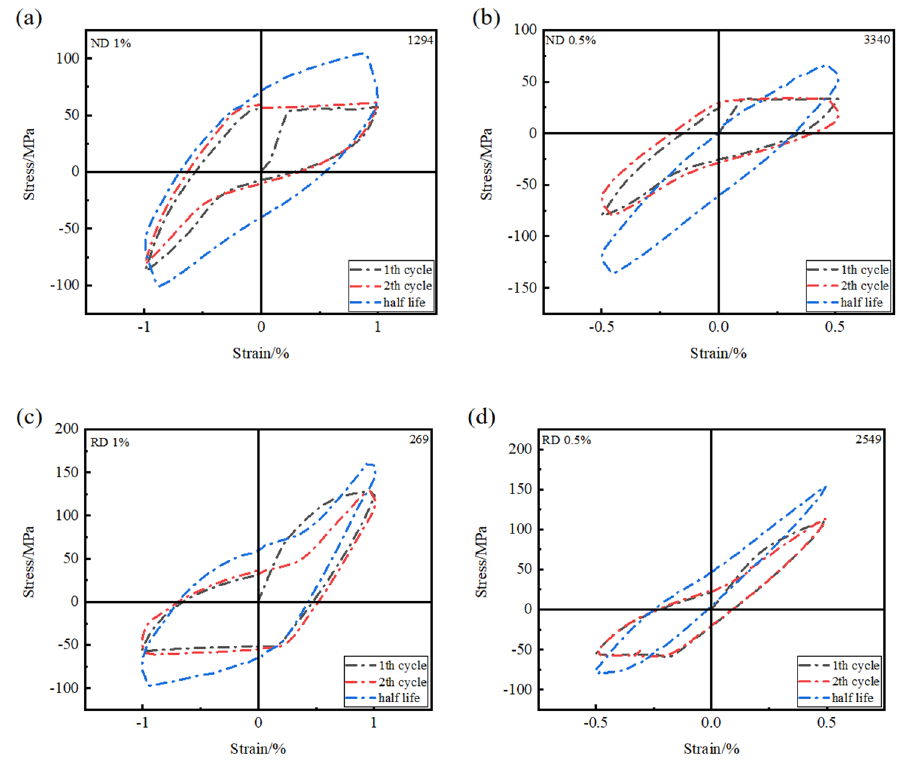
Figure 2. Stress–strain curves of samples under different strain and directions: ( a ) strain amplitude of 1% along ND; ( b ) strain amplitude of 0.5% along ND; ( c ) strain amplitude of 1% along RD; ( d ) strain amplitude of 0.5% along RD.